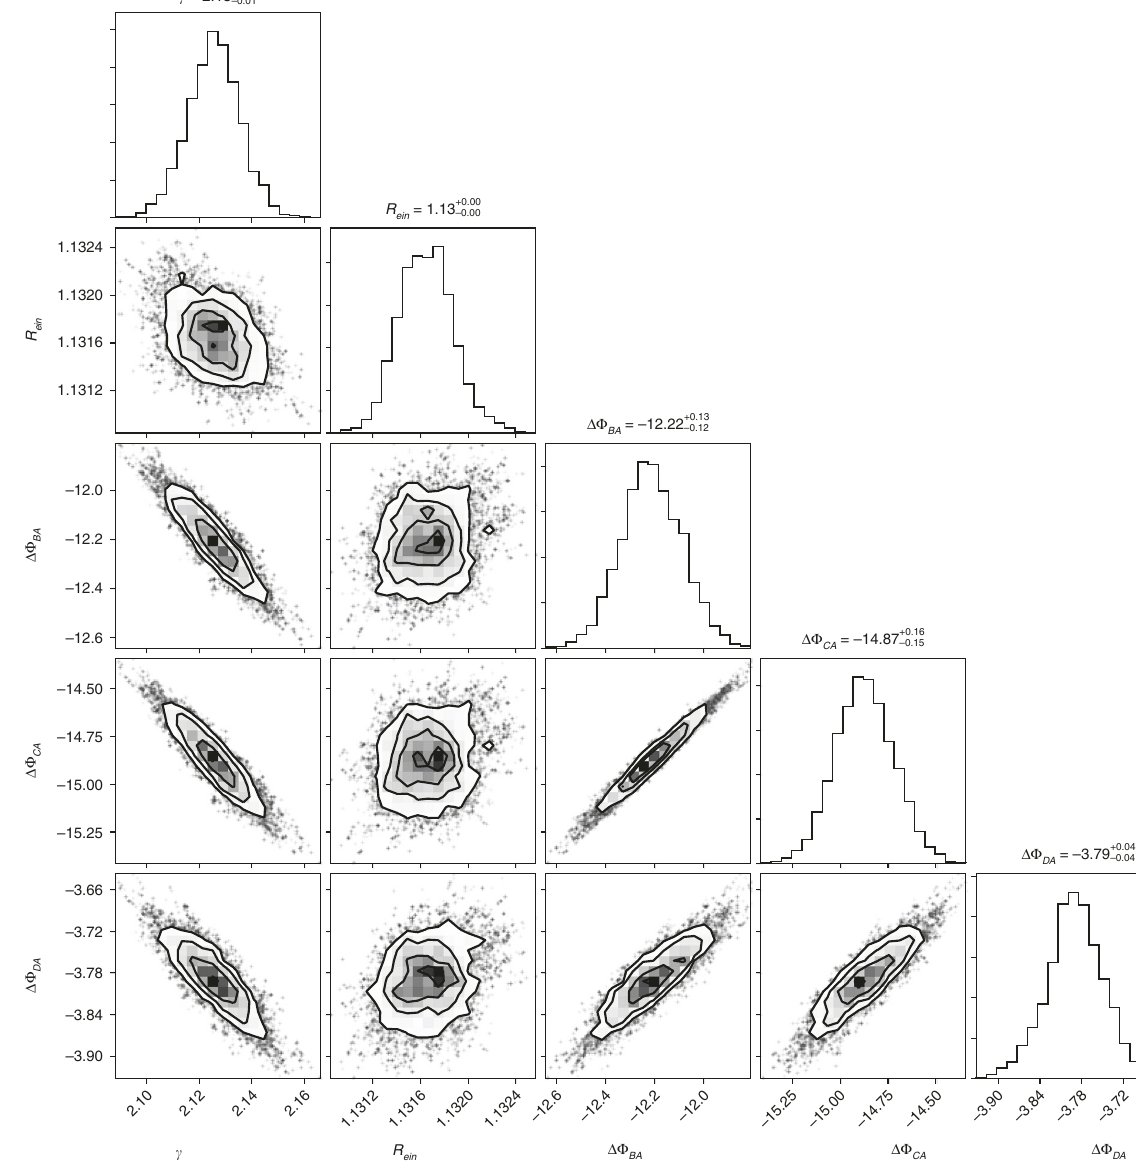
Fig. 4 The contours of parameters inferred from the MCMC technique. The demonstrated parameters are the Einstein radius R ein (in units of arcsecond), power-law mass pro fi le slope γ , and differences of Fermat potentials between each pair of images. Note that Fermat potentials have no units, and we have re-scaled their values to better present the uncertainty